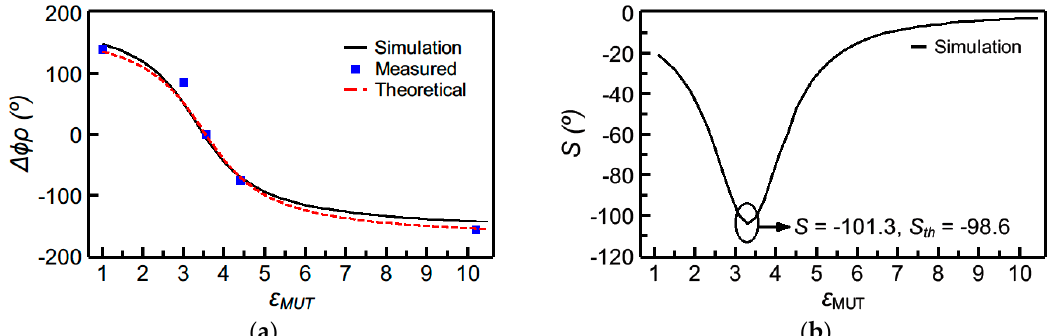
Figure 3. Detail of one of the sensors covered by the material under test (MUT). In order to avoid the presence of an air gap between the MUT sample and the sensing line, the sample was pressured against the sensing line by means of Teflon screws.